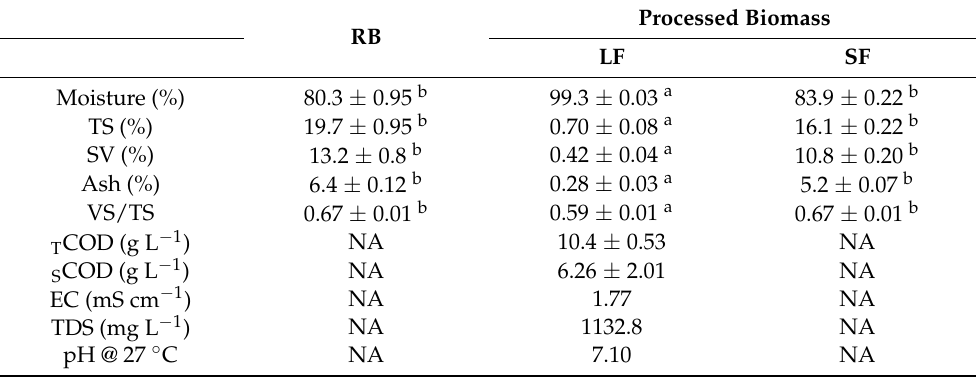
Table 1. Physicochemical analysis of raw (RB) and processed Sargassum spp. biomass from the Mexican Caribbean: liquid (LF) and solid fractions (SF) on a wet basis ( n = 3). Means with different superscripts in rows indicate statistically significant differences between samples ( p <